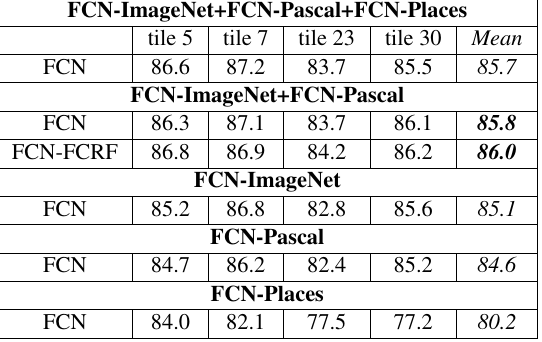
Table 1: Overall accuracies over the four images of our hold- out set. The fully connected CRF (FCN-FCRF) is only tested with the top-performing FCN ensemble (FCN-ImageNet+FCN- Pascal). We report overall accuracies per scene, and average over- all accuracy across all four scenes (all numbers in %).